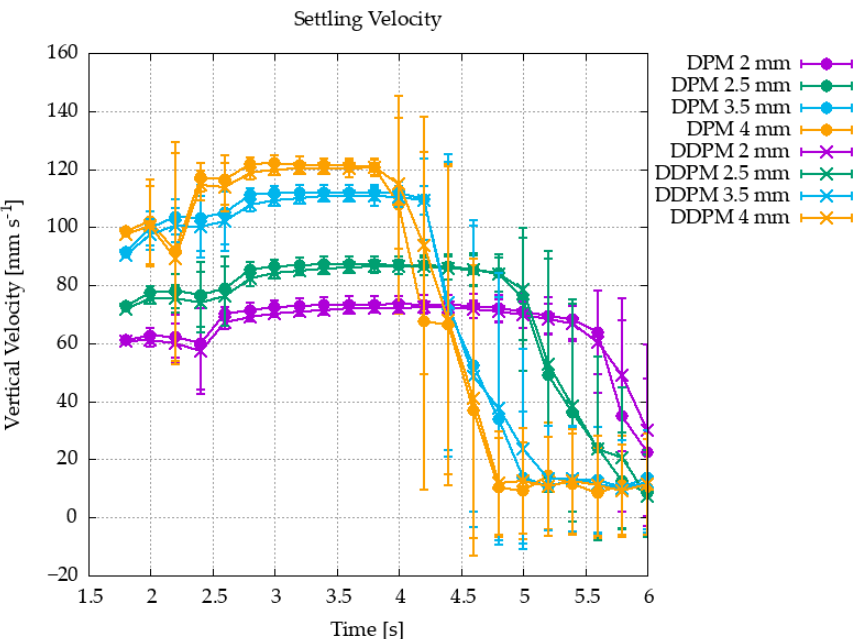
Figure 9. Settling velocity of plastic particles; points represent average values, and error bars represent one standard deviation.